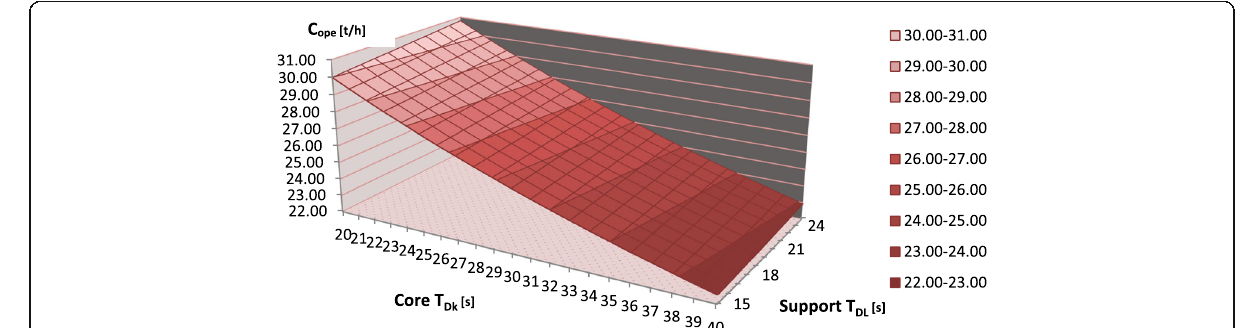
Fig. 12 Operative Capacity sensitivity analysis. Possibility ( α obj ) = 0,7 Necessity= 0